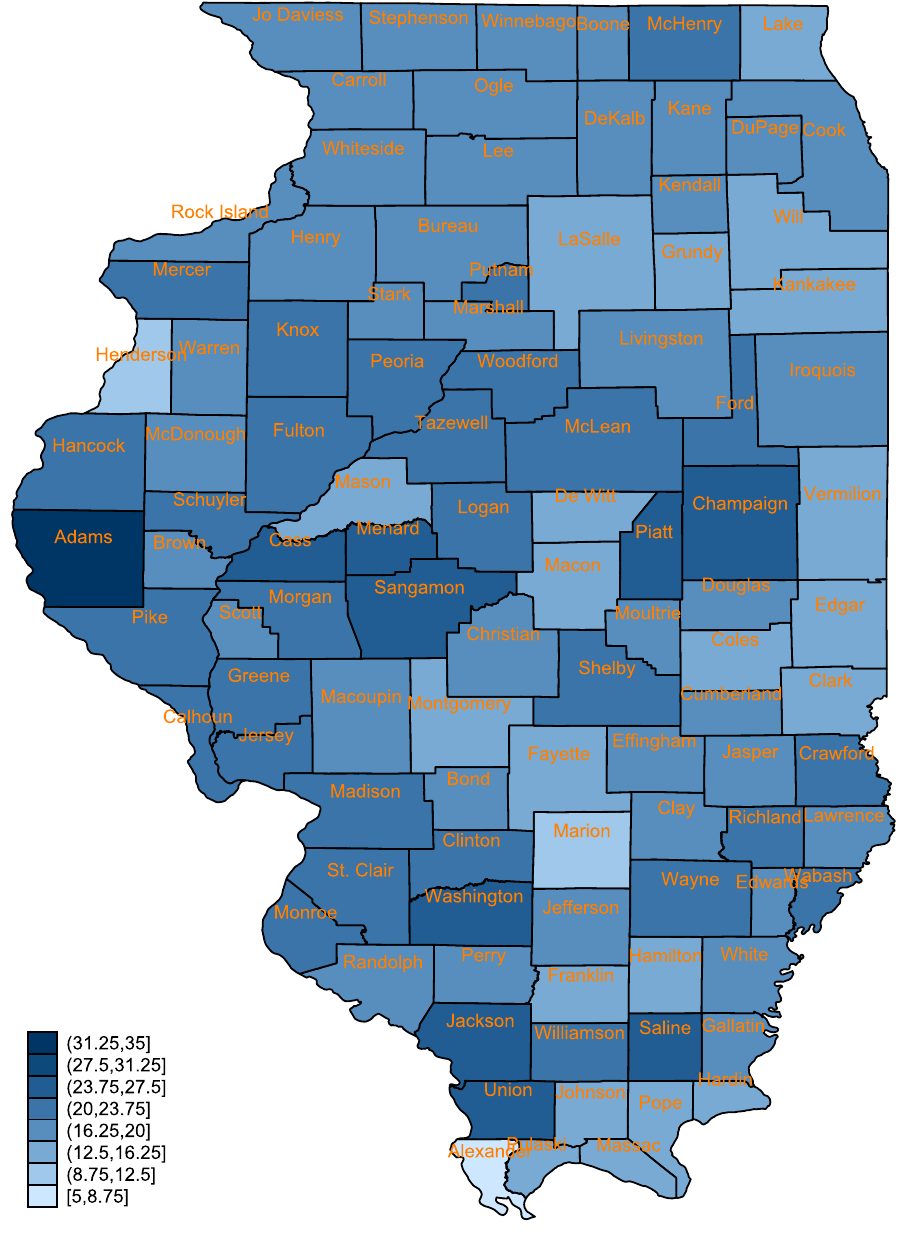
Figure 1. Percent fully vaccinated population across Illinois counties as of April 3, 2021. The map was generated with the command grmap, Stata version 16.0